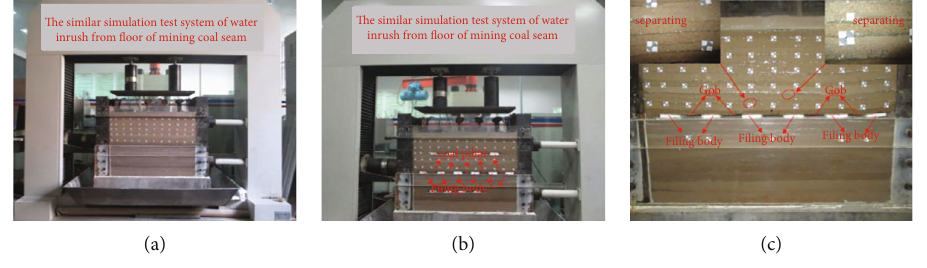
Figure 15: Excavation in the physical